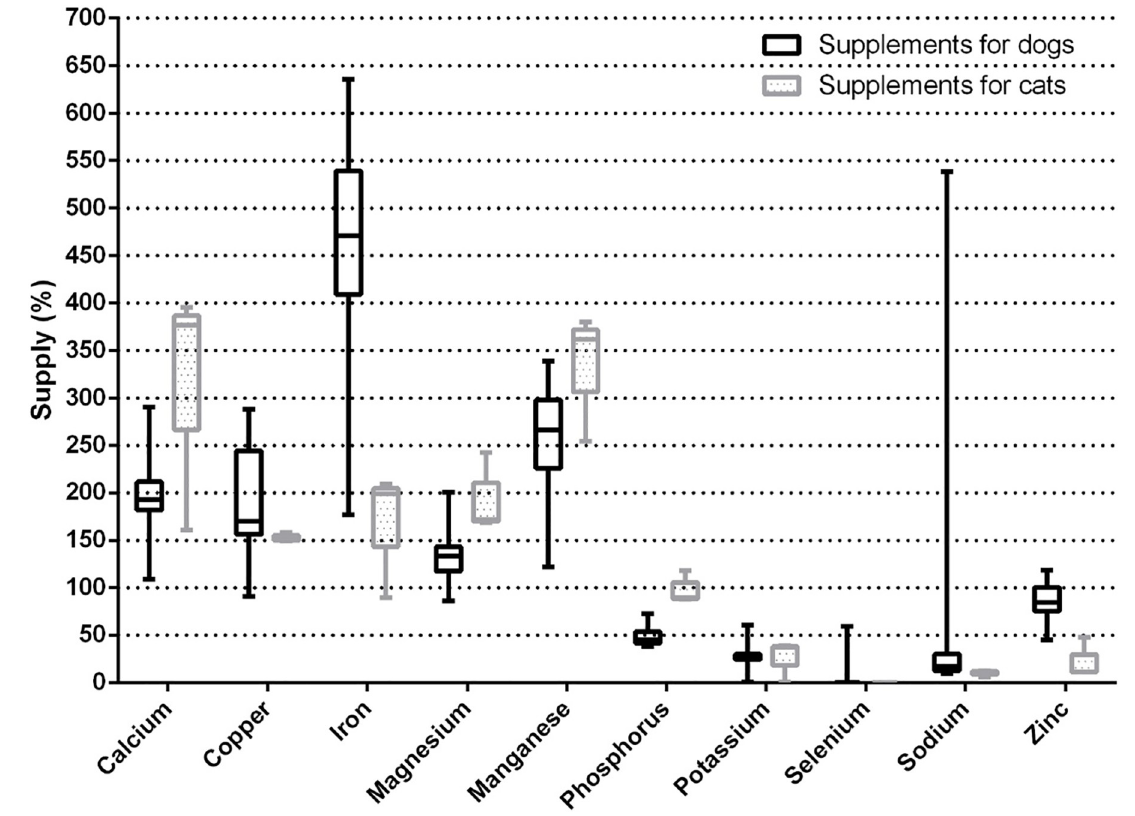
Fig 1. Box-and-whiskers plot of the percentages of mineral supply of the analyzed supplements according to the recommendations of NRC (2006) in mg/kg of metabolic weight (BW 0.75 for dogs and BW 0.67 for cats).